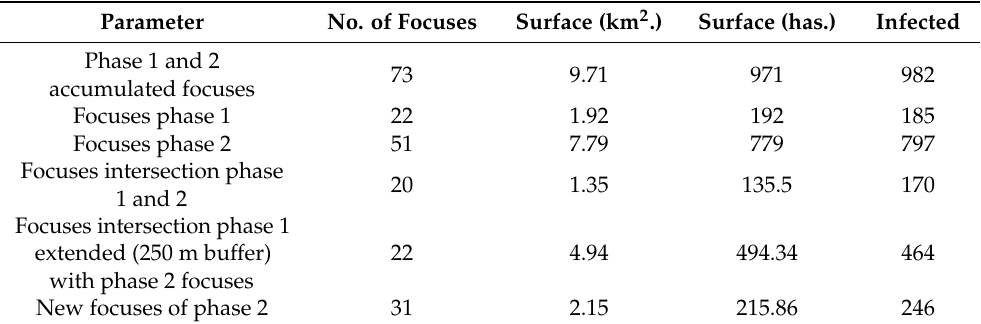
Table 6. Quantification of the degree of spatio-temporal permanence of the contagion focuses in two successive bi-weekly